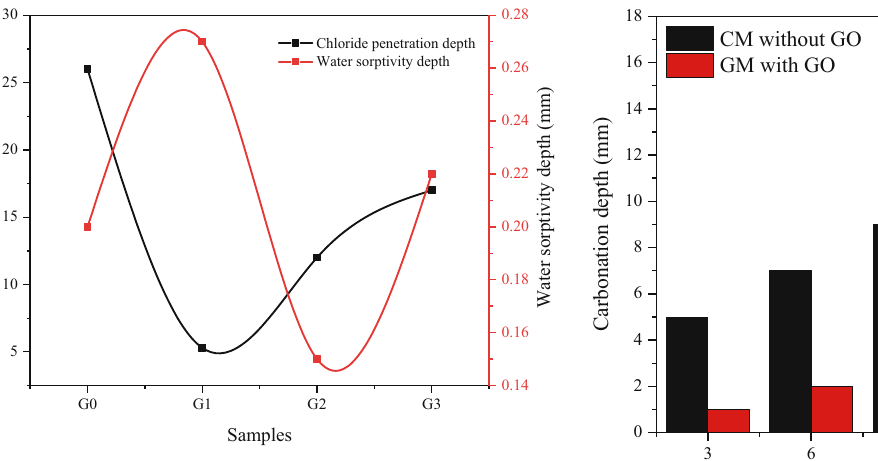
Figure 6: Chloride penetration depth and water sorptivity depth of the GO - modi fi ed mortar: G0 without GO, G1 with 0.01% GO, G2 with 0.03% GO, and G3 with 0.06% GO [ 79 ] . Figure 7: Carbonation depth of the GO